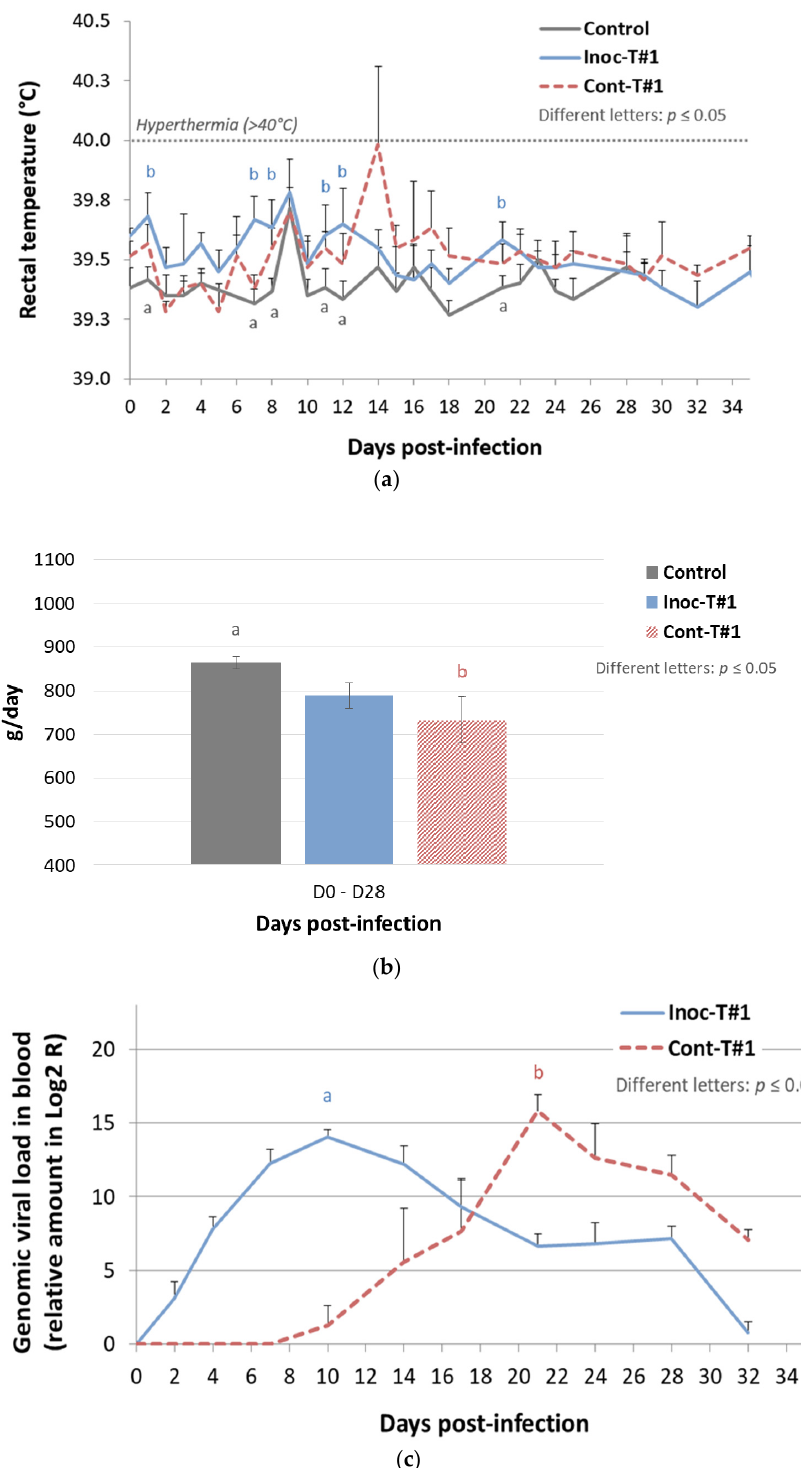
Figure 2. Results from Trial#1. Evolution of the mean rectal temperatures (°C) ( a ) and of the average daily weight gain (ADWG) (g/day) ( b ) in inoculated Trial#1 (Inoc-T#1) pigs and in contact Trial#1 (Cont-T#1) pigs after inoculation (day 0). Different letters (“a” and “b”) indicate that the groups are significantly different from each other with p ≤ 0.05. ( c ) Evolution of the mean genomic viral loads in blood (relative amount expressed in Log2 R) in Inoc-T#1 inoculated pigs and in Cont-T#1 contact pigs after inoculation (day 0). Different letters (“a” and “b”) indicate that the groups are significantly different at peak values from each other with p ≤ 0.05.